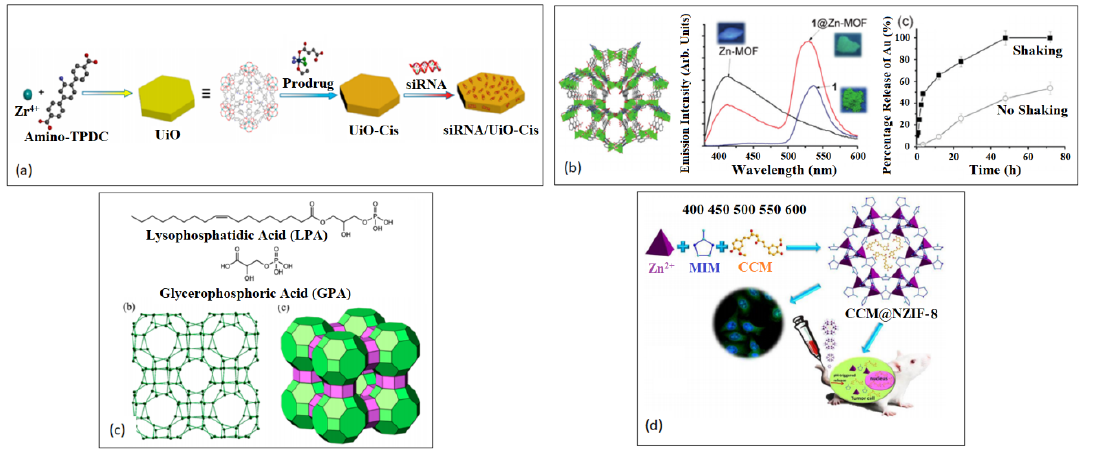
Figure 17. Applications of chemically modified BioMOF nanostructures for Ovarian ( a , b ) and Cer- vical ( c , d ) Cancer treatment. ( a ) siRNA/Cis/UiO. Reproduced with permission from Ref. [74]. Copyright © 2014, American Chemical Society. ( b ) Zn-MOF. Reproduced with permission from Ref. [76]. Copyright © 2018, Wiley. ( c ) Eu Tb-ZMOF. Reproduced with permission from Ref. [75]. Copy- right © 2015, American Chemical Society. ( d ) CCM@NZIF-8. Reproduced with permission from Ref. [83]. Copyright © 2015, American Chemical Society.